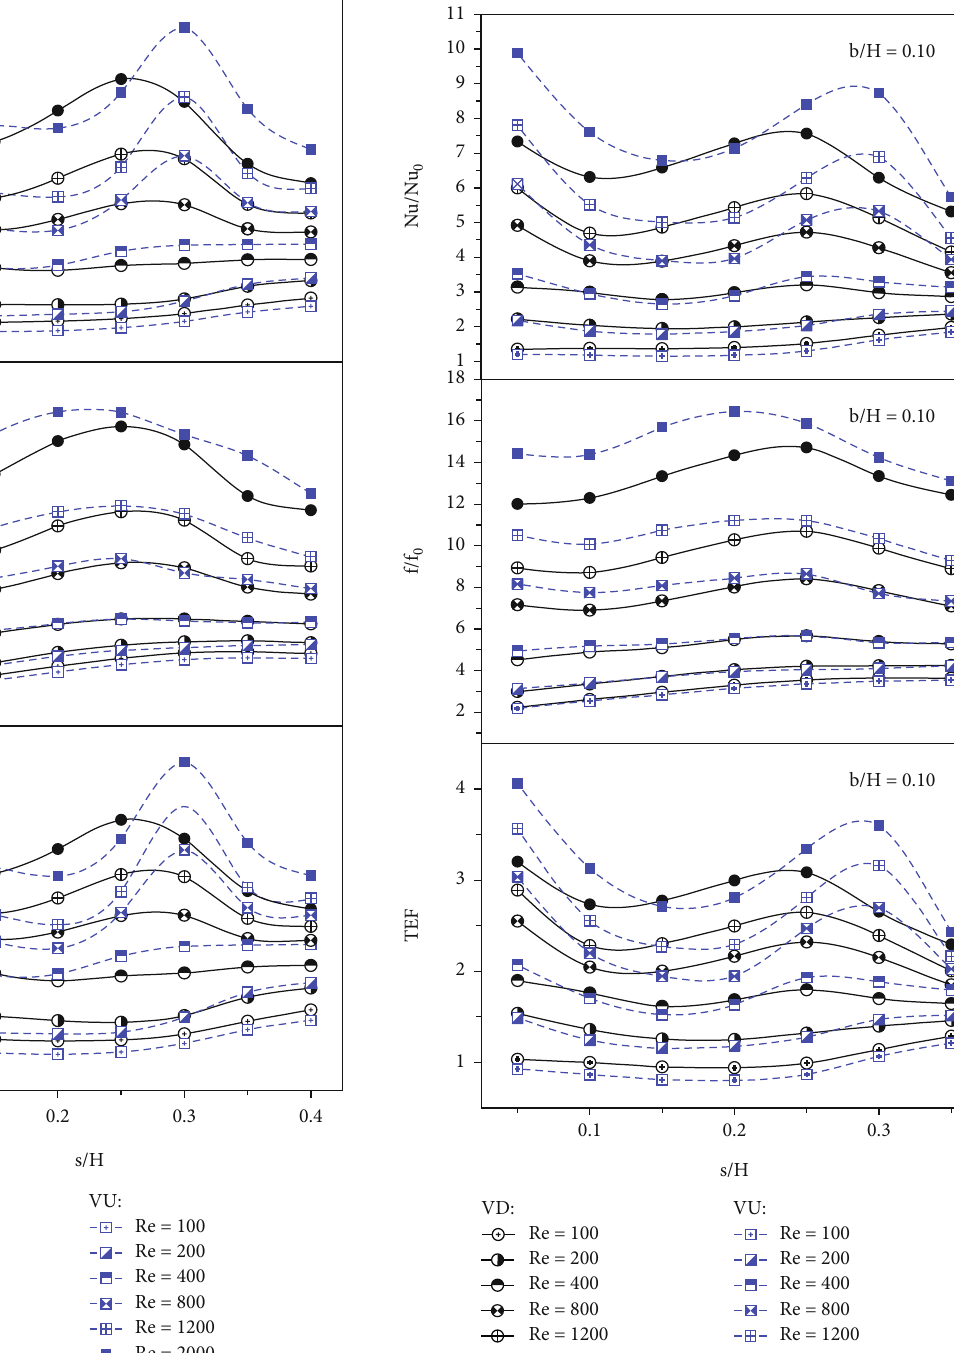
10: Thermal performance analysis of b / H = 0 : 10